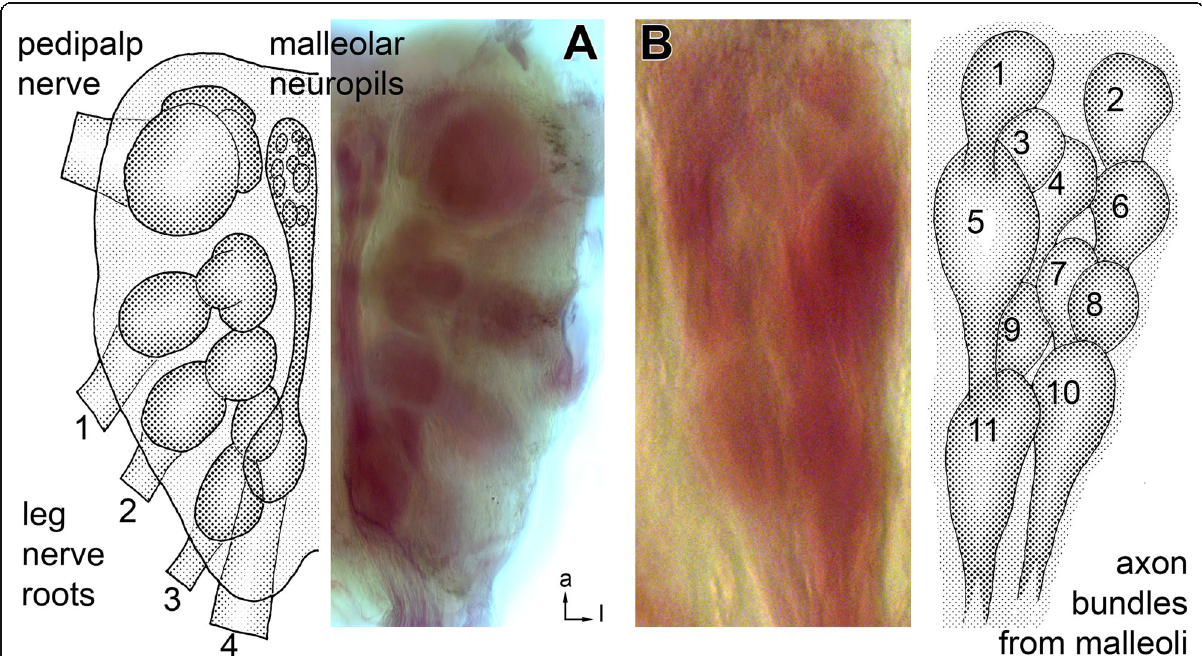
Fig. 5 Glomerular organization of the malleolar neuropil, overview. a Galeodes arabs subesophageal synganglion in ventral view. Microscopic image of a malleolus backfill preparation (right) with corresponding schematic drawing (left). In this backfill, some Ni ++ -ions have seeped into all neuropils of the prosomal synganglion, providing an overview of ganglion anatomy. Nerve roots of pedipalp and first to fourth walking legs are labelled. The malleolar neuropils are located anteriorly close to the synganglion midline. b Detail from the preparation in A, taken from the other ganglion half. Drawing on the right outlines the 11 – 13 glomeruli that are identified when focusing through the depth of the preparation; glomeruli 5 and 11 may represent two separate glomeruli. Numbering is according to the appearance in transversal section series (Fig. 6b). Afferent axon supply from posterior is indicated. For all images, anterior is to the top and lateral to the